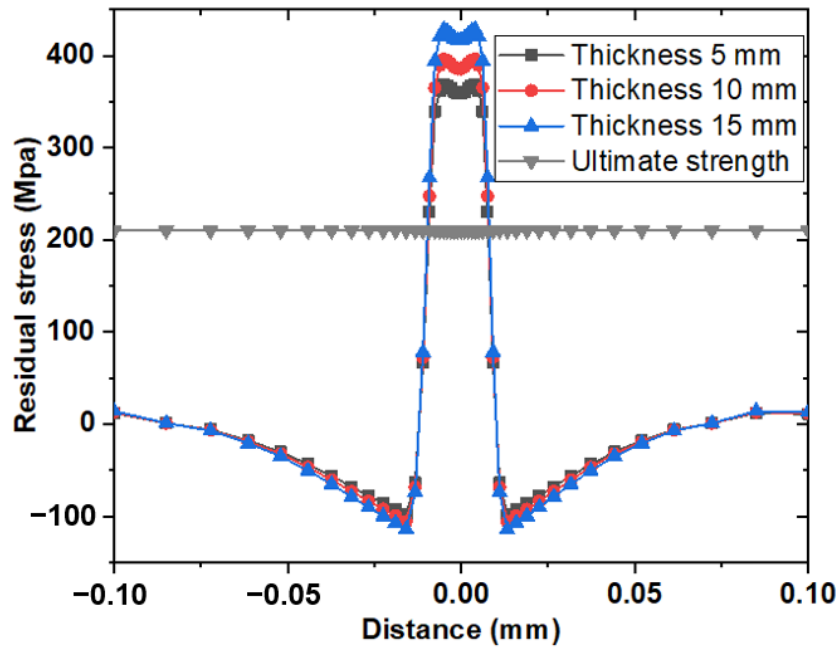
Figure 14. Residual stress along the transverse direction with different plate thicknesses.